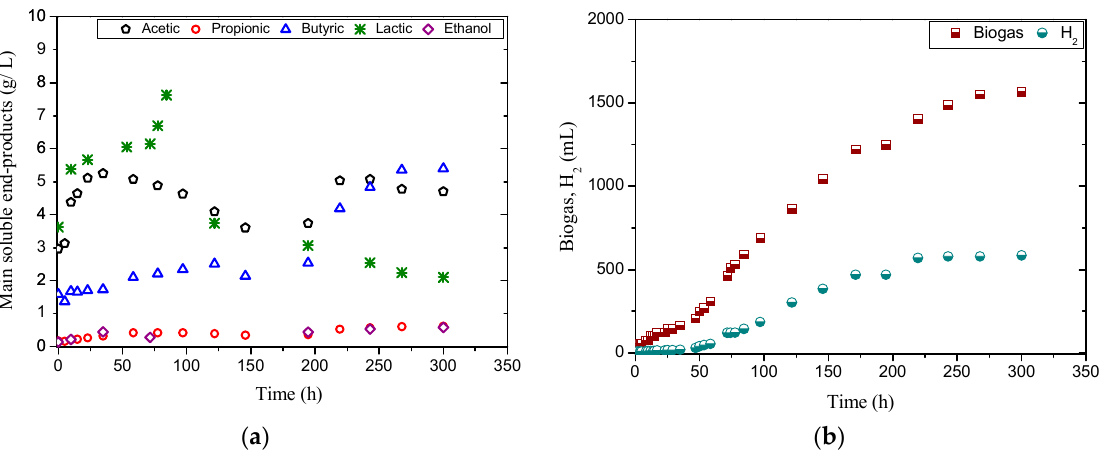
Figure 4. ( a ) Evolution of main VFAs, lactic acid, and ethanol and ( b ) gaseous products (biogas and hydrogen) during batch acidogenesis of mixture (95% ES and 5% LCM), at pH 5.0.